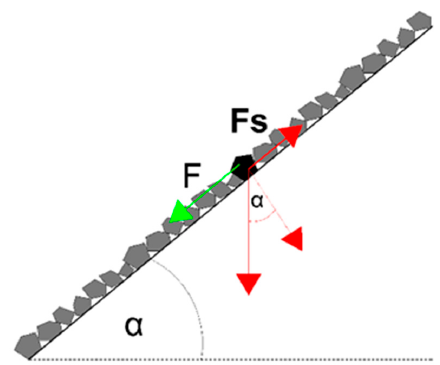
Figure 8. Inclined plane used for measurements of coefficient of static friction.